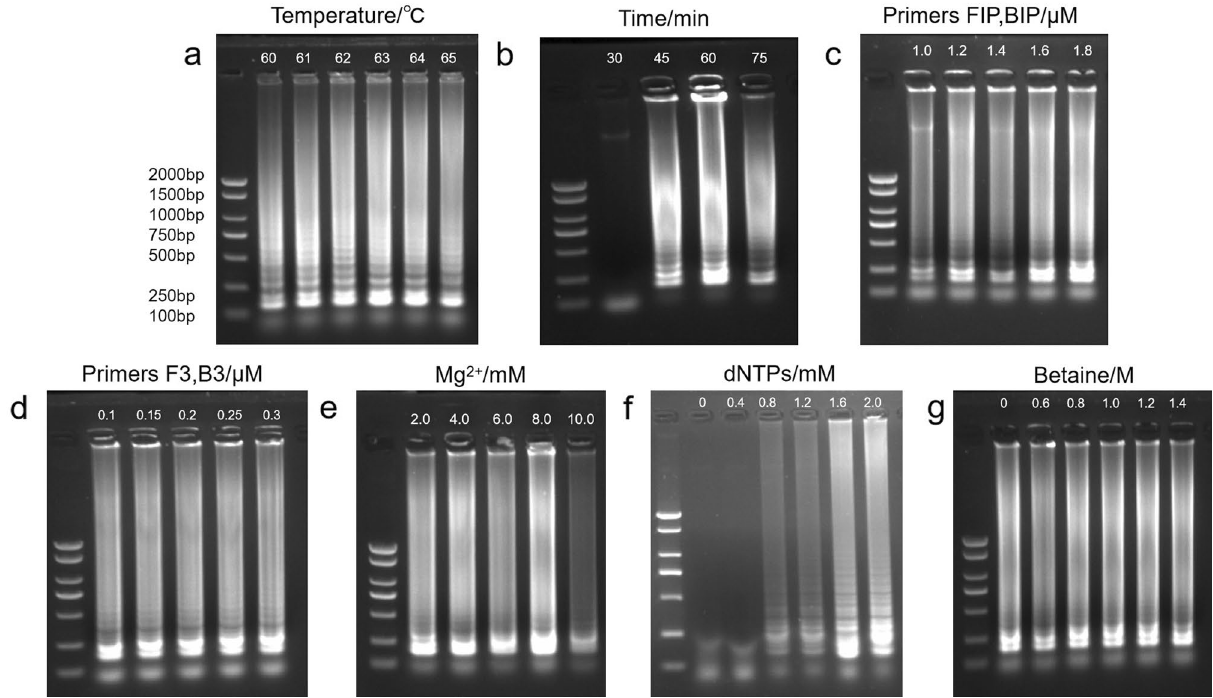
Figure 4. Optimization of the LAMP system to detect SVBV. ( a ) temperature: 60, 61, 62, 63, 64, 65 °C; ( b ) time: 30, 45, 60, 75 min; ( c ) primers FIP/BIP: 1.0, 1.2, 1.4, 1.6, 1.8 μM; ( d ) primers F3/B3: 0.1, 0.15, 0.2, 0.25, 0.3 μM; ( e ) Mg 2+ : 2.0, 4.0, 6.0, 8.0, 10.0 mM; ( f ) dNTPs: 0, 0.4, 0.8, 1.2, 1.6, 2.0 mM; ( g ) Betaine: 0, 0.6, 0.8, 1.0,